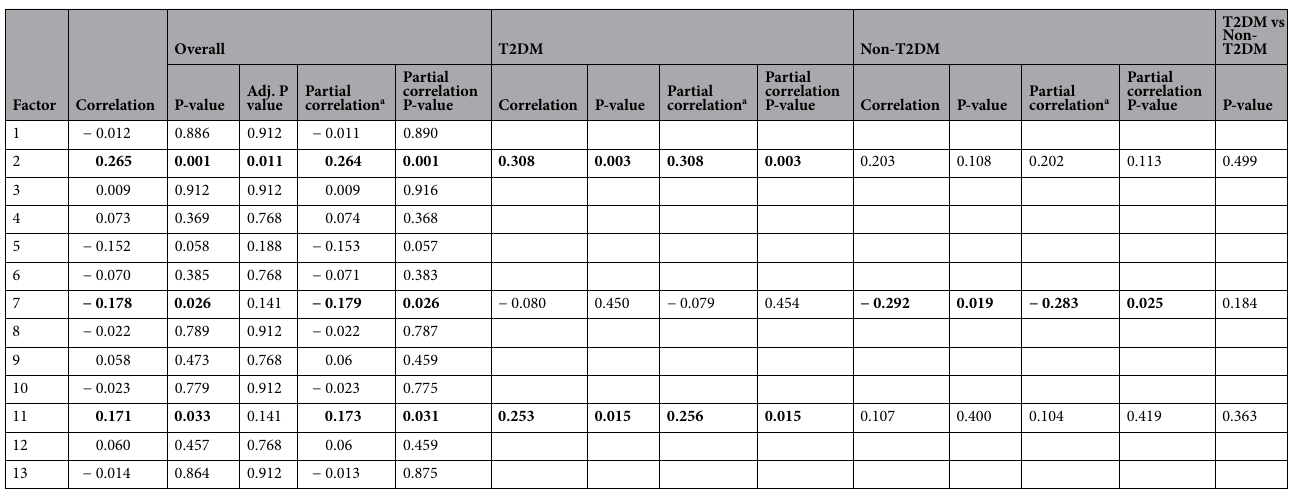
Table 3. Spearman correlation analyses between 90-day change in metabolite factor level and 90-day change in 6-minute walk distance. Significant values are in bold. a Partial correlations adjusted for treatment